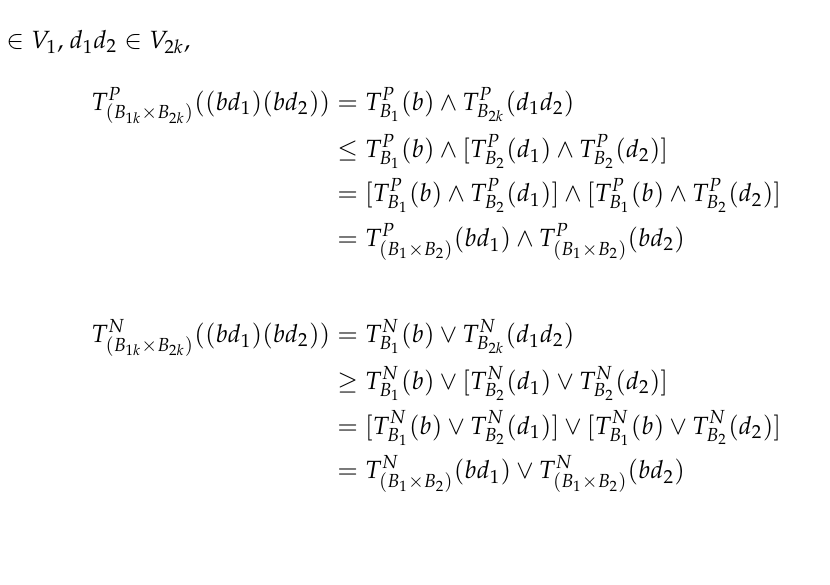
Figure 2.11: ˇ G b 1 × ˇ G b 2 Figure 11. ˇ G b 1 × ˇ G b 2 .